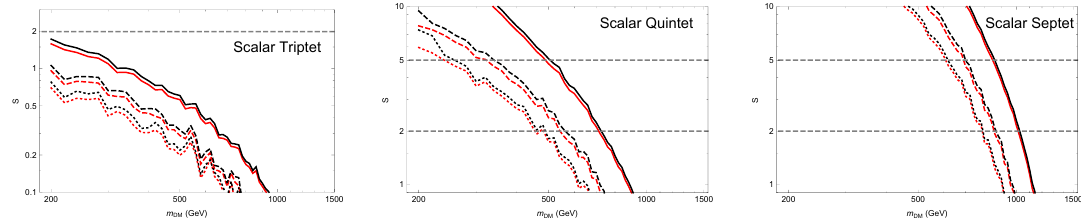
Figure 10 . Signi(cid:12)cances for scalar EMDM for 2 ab (cid:0) 1 of CLIC data in the mono-photon channel for, from left to right, the real scalar triplet, quintet, and septet respectively. The notation is as in (cid:12)gure